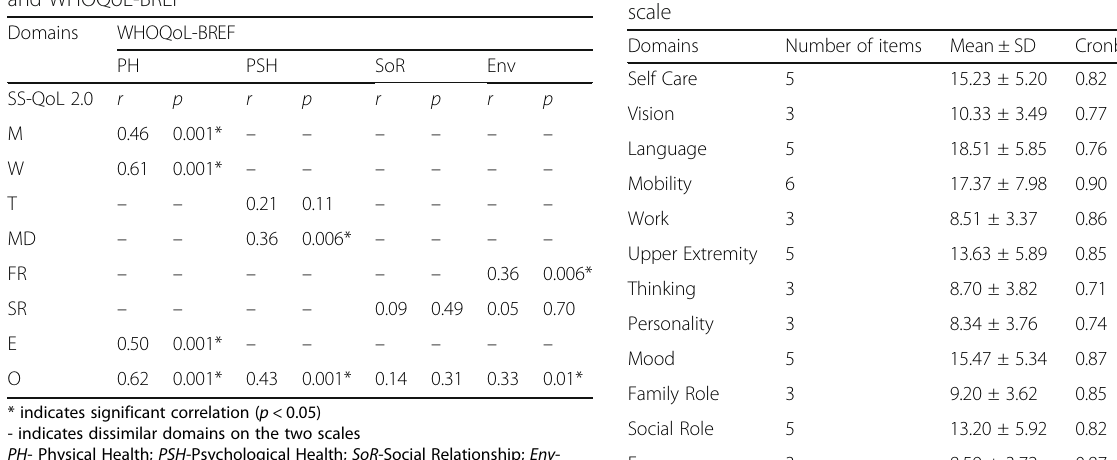
Table 9 Cronbach ’ s alpha values of Hausa version of SS-QoL